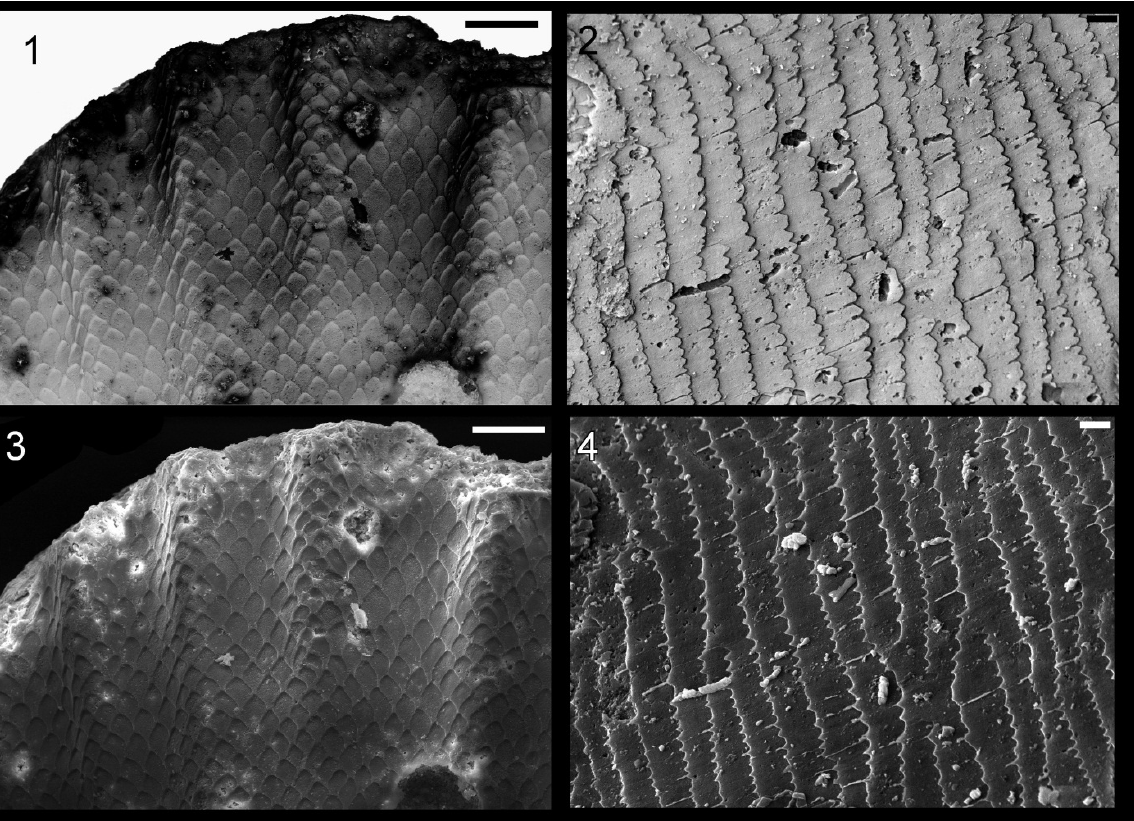
Figure 8. Imprints of shell microstructure in the brachiopod Zygospira ( 1 ) and ( 3 ) and a trilobite spine ( 2 ) and ( 4 ) from the “Arnheim Formation” Cyclora beds of Ohio. Images ( 1 ) and ( 2 ) are electronically inverted versions of the originals in ( 3 ) and ( 4 ), to show what the crystal structures imprinted in the fossils originally looked like. ( 1 ) and ( 3 ) Zygospira sp., LACMIP 14448, from the “Arnheim Formation” near Kemper Road, Cincinnati, Ohio, horizontal surface of internal mould; and ( 2 ) and ( 4 ) trilobite spine, LACMIP 14449, possibly from the “Arnheim Formation”, Hamilton, Ohio, horizontal surface of internal mould. Scale bars: 50 µm for ( 1 ) and ( 3 ); and 5 µm for ( 2 ) and ( 4